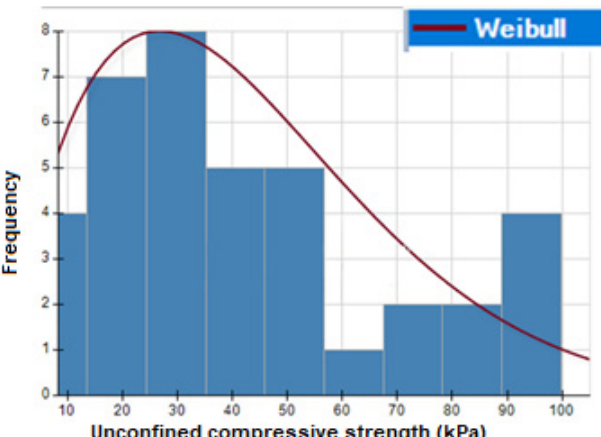
Figure 12. Adequate theoretical functions for the distribution of shear resistance data measured by UCS test.